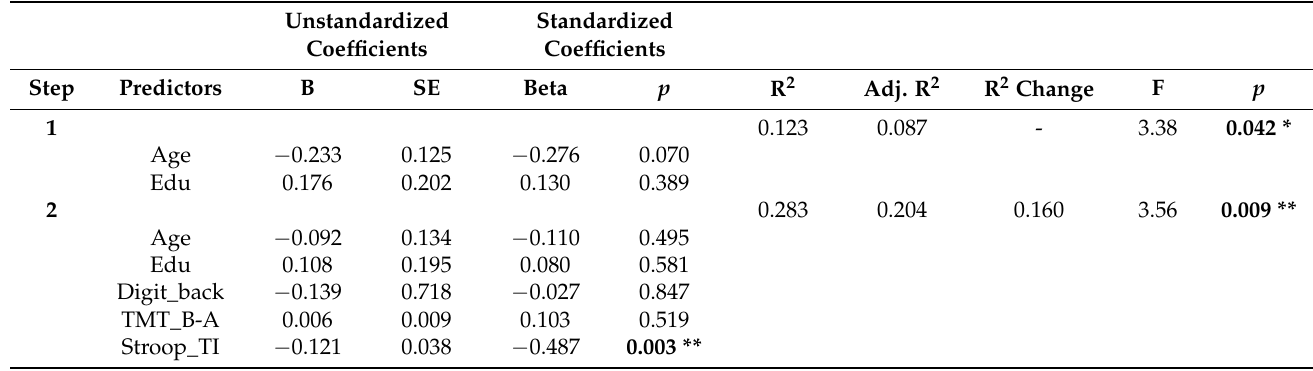
Table 4. Hierarchical regression with PWB_PG (personal growth) as VD, age and EDU (educational level) as control variables in the first block and the three core executive functions (Digit backwards, TMT B-A and the Stroop’ time interference) as predictors in the second block. N = 51; SE = Standard error; Adj. =